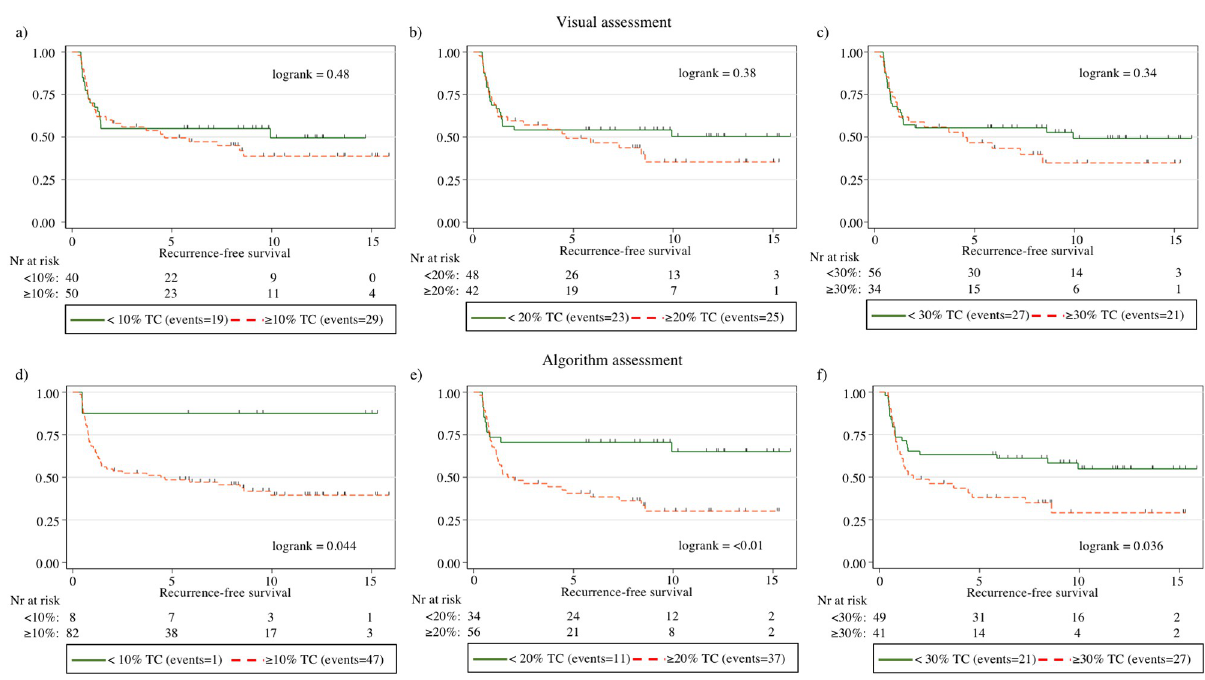
Fig 4. Kaplan–Meier curves for relapse-free survival (RFS) among patients with papillary thyroid cancer according to three tall cell percentage thresholds: 10%, 20%, and 30% based on visual assessment (a–c) and using the algorithmic assessment (d–f). In the figure, tall cell is abbreviated as